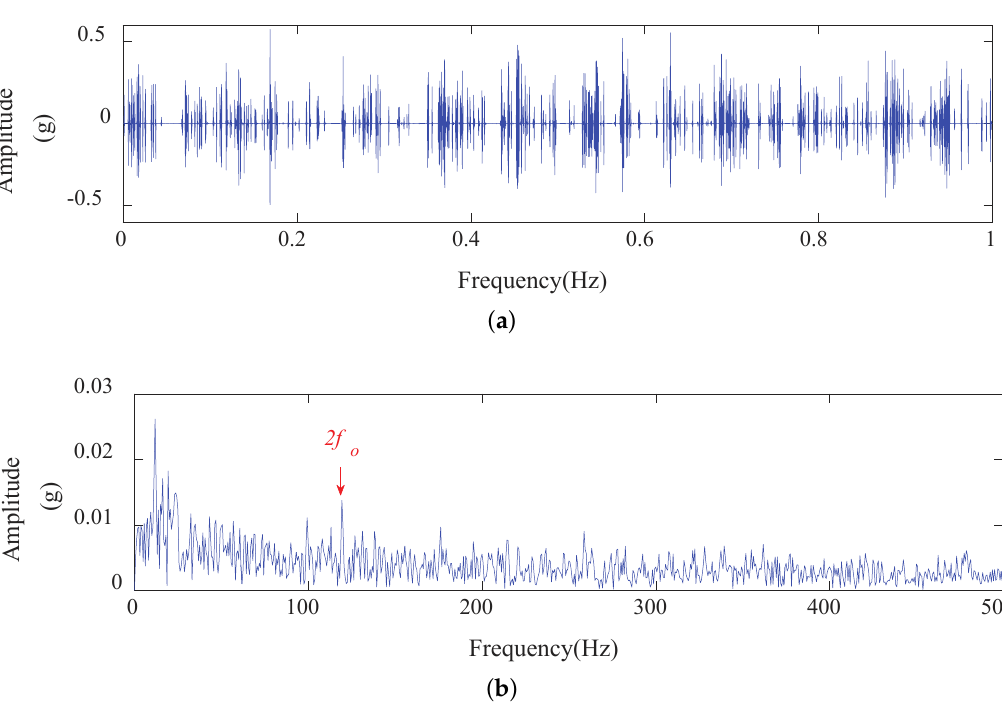
Figure 22. Results of TQWT: ( a ) High oscillatory component. ( b ) Low oscillatory component. ( c ) Residual component.